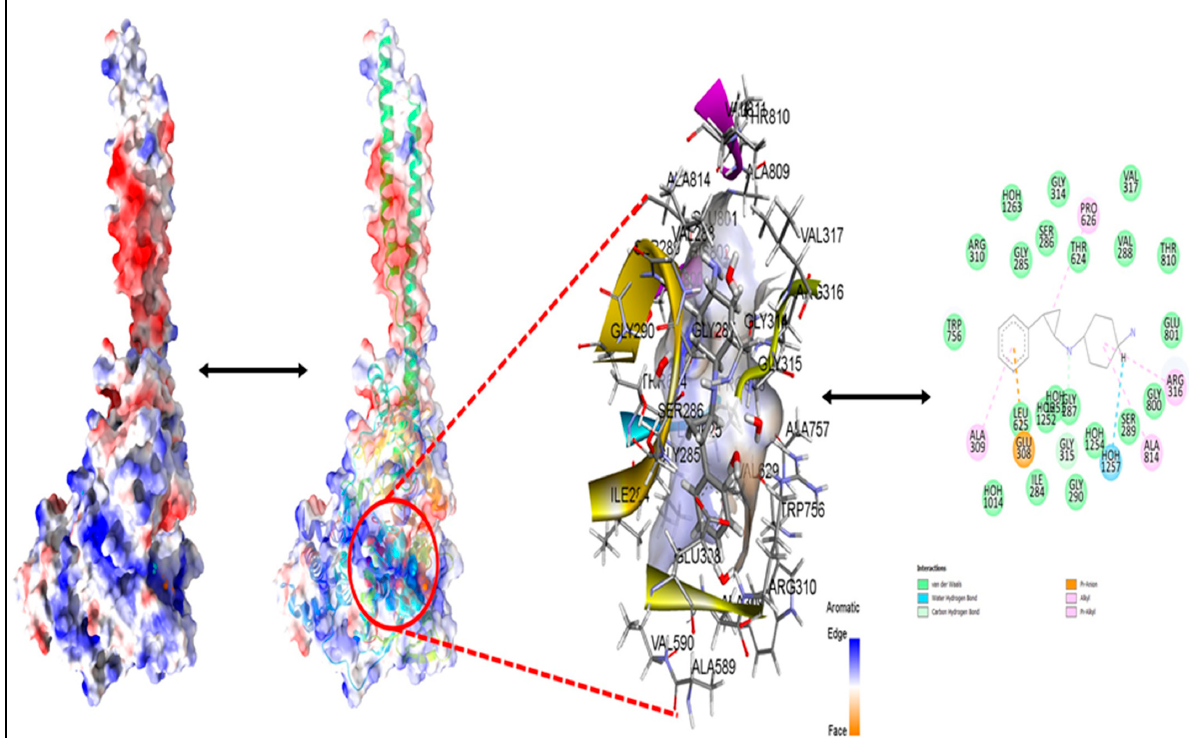
Figure 14. Best docked pose of compound 1 with LSD displaying 2D interaction plot on the left panel. Pink dashed lines indicate the Pi-Alkyl bond, and residues embedded in light green sphere indicate the involvement in Van der Waals interactions. On the canter panel, surface view of LSD displaying binding cavity of Compound 1 and right panel displaying the zoomed out binding pocket having amino acid residues surrounding the Compound 1 .